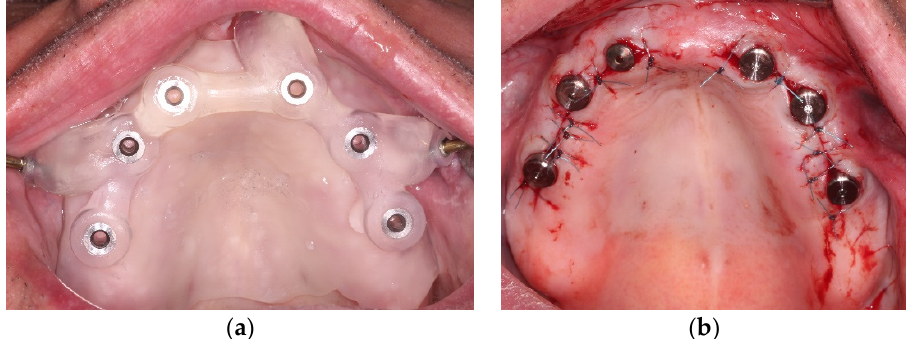
Figure 2. The surgical procedure: ( a ) The mucosa-supported, pin-anchored surgical template in place; ( b ) The implants placed in the edentulous upper jaw.